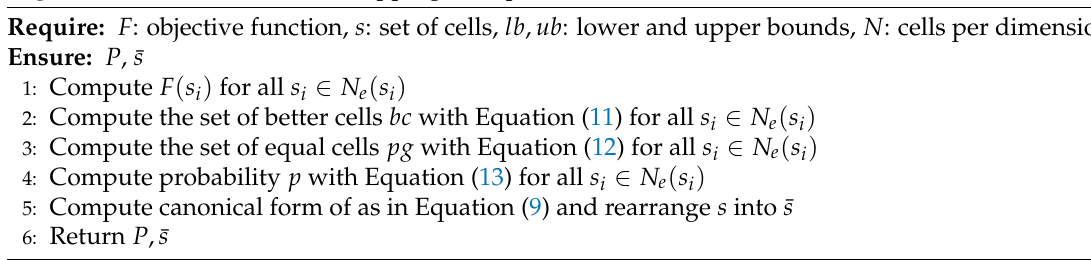
Algorithm 2 Generalized Cell Mapping for